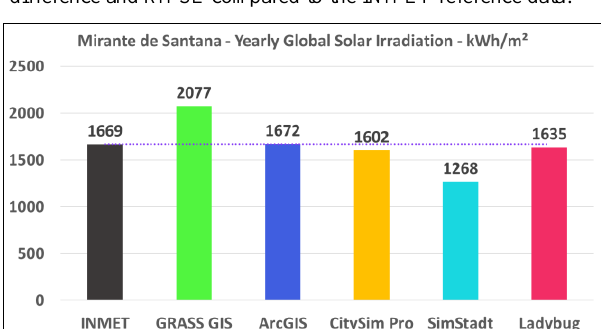
Table 2. Yearly global solar irradiation (YGSR) in [kWh/m 2 /a], difference and RMSE compared to the INMET reference data.